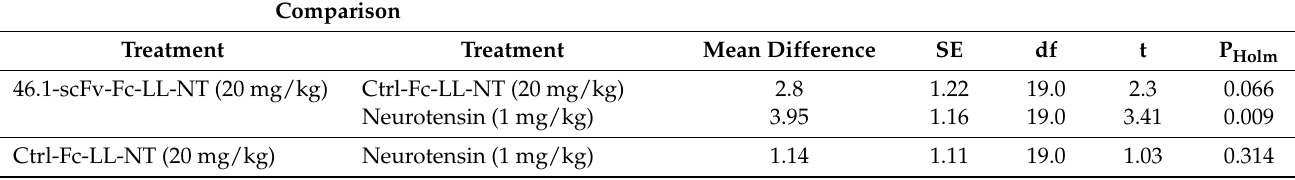
Table A1. The statistical parameters for the NT activity assay.